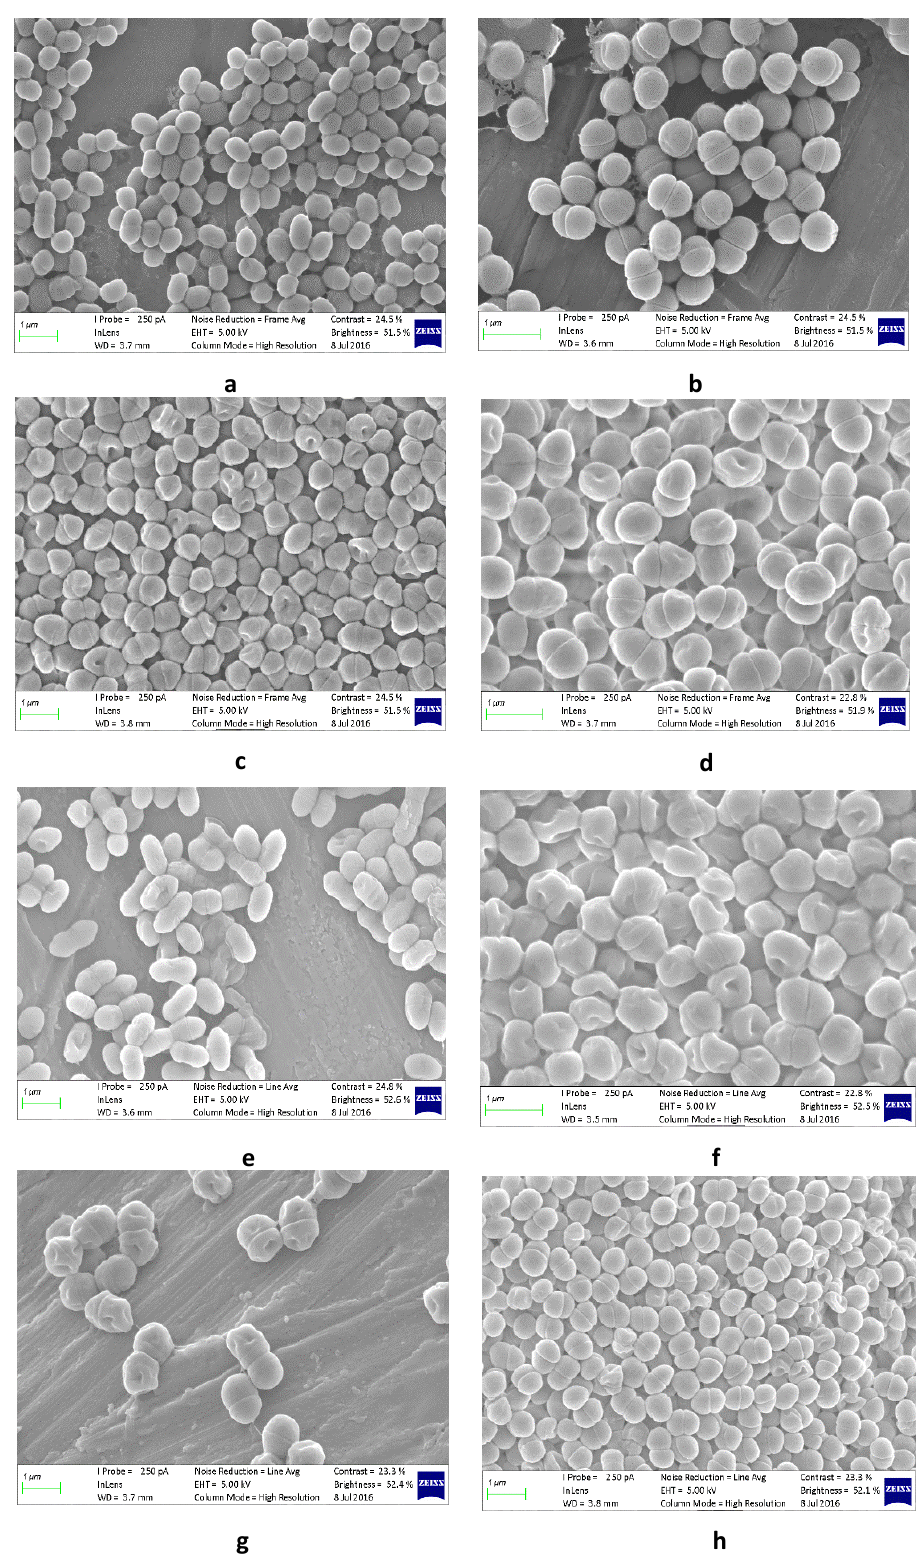
Figure 5. Scanning electron microscopy of bacterial cells isolated from pearl millet slurry during fermentation. Tentative identities: ( a ) Leuconostoc mesenteroides ssp . dextranicum (1 µm) , ( b ) Pediococcus pentosaceus (1 µm) , ( c ) Enterococcus durans (1 µm) , ( d ) Streptococcus thoraltensis (1 µm) , ( e ) Enterococcus gallinarum (2 µm) , ( f ) Enterococcus casseliflavus (1 µm) , ( g ) Enterococcus faecium and ( h ) Enterococcus avium (1 µm).